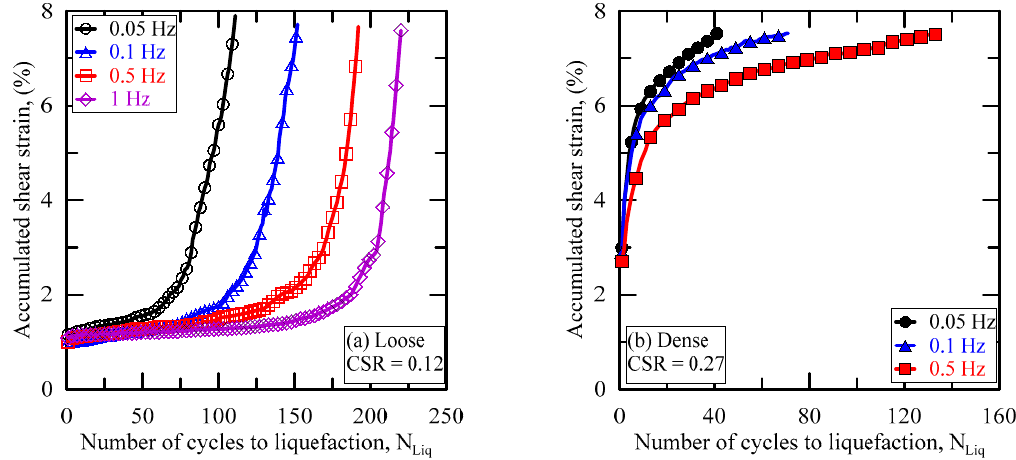
Figure 10. Evolution of accumulated shear strain ( a ) loose sand for CSR = 0.12 and ( b ) dense sand for CSR = 0.27 effected by various loading frequencies at σ v0 ′ = 100 kPa.